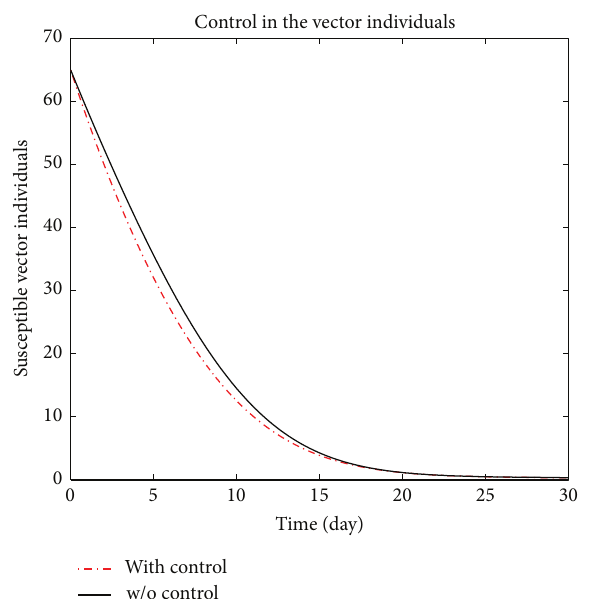
Figure 7: Plot of thenumber of susceptiblevectors with and without control, 𝑢 1 = 0 , 𝑢 2 ̸= 0 .